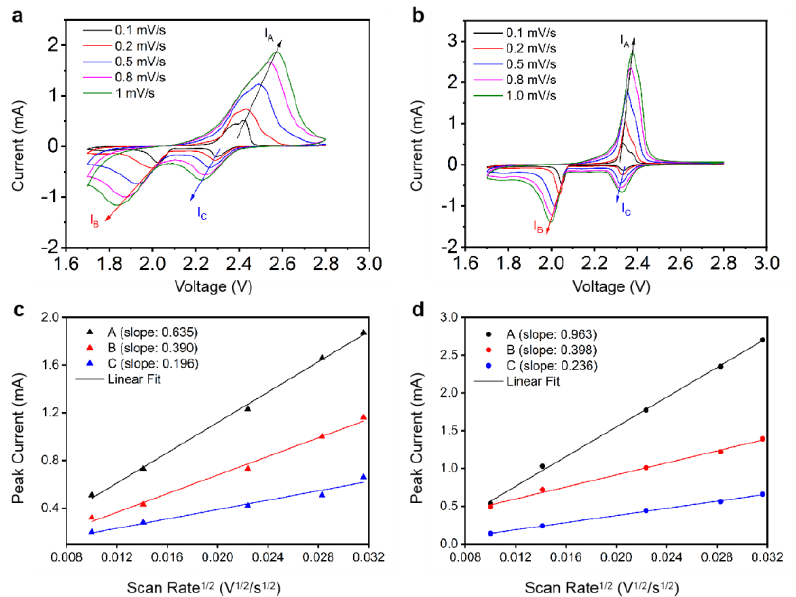
Figure 5. CV curves and corresponding linear fits of the peak currents of Li-S cells with ( a , c ) S/ZIF-67 cathode and ( b , d ) S/Co-NC600 cathode. Table 2. The value of the lithium ion diffusion coefficient and Warburg coefficient in the two types of